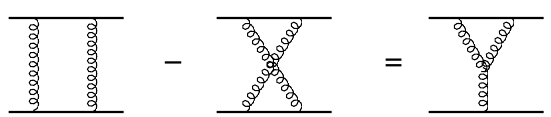
Figure 2. Reggeization corrections to a single gluon exchange.